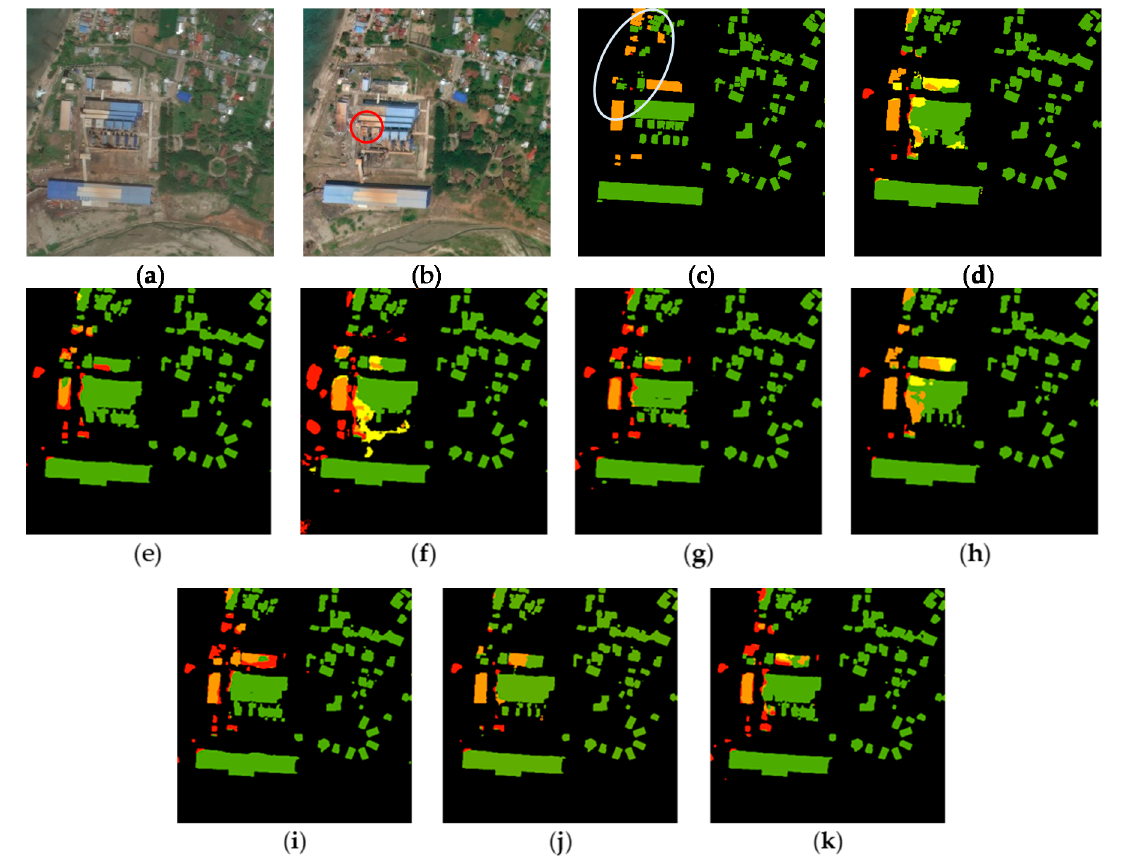
Figure 11. Palu_00000004 in the verification set. ( a ) A pre-disaster image, ( b ) a post-disaster image and ( c ) the ground truth (GT). ( d ) The result of ResNet (w/o A), ( e ) the result of SEresNeXt (w/o A), ( f ) the result of DPN (w/o A), ( g ) the result of SENet (w/o A), ( h ) the result of ResNet (w A), ( i ) the result of SEresNeXt (w A), ( j ) the result of DPN (w A) and ( k ) the result of SENet (w A).